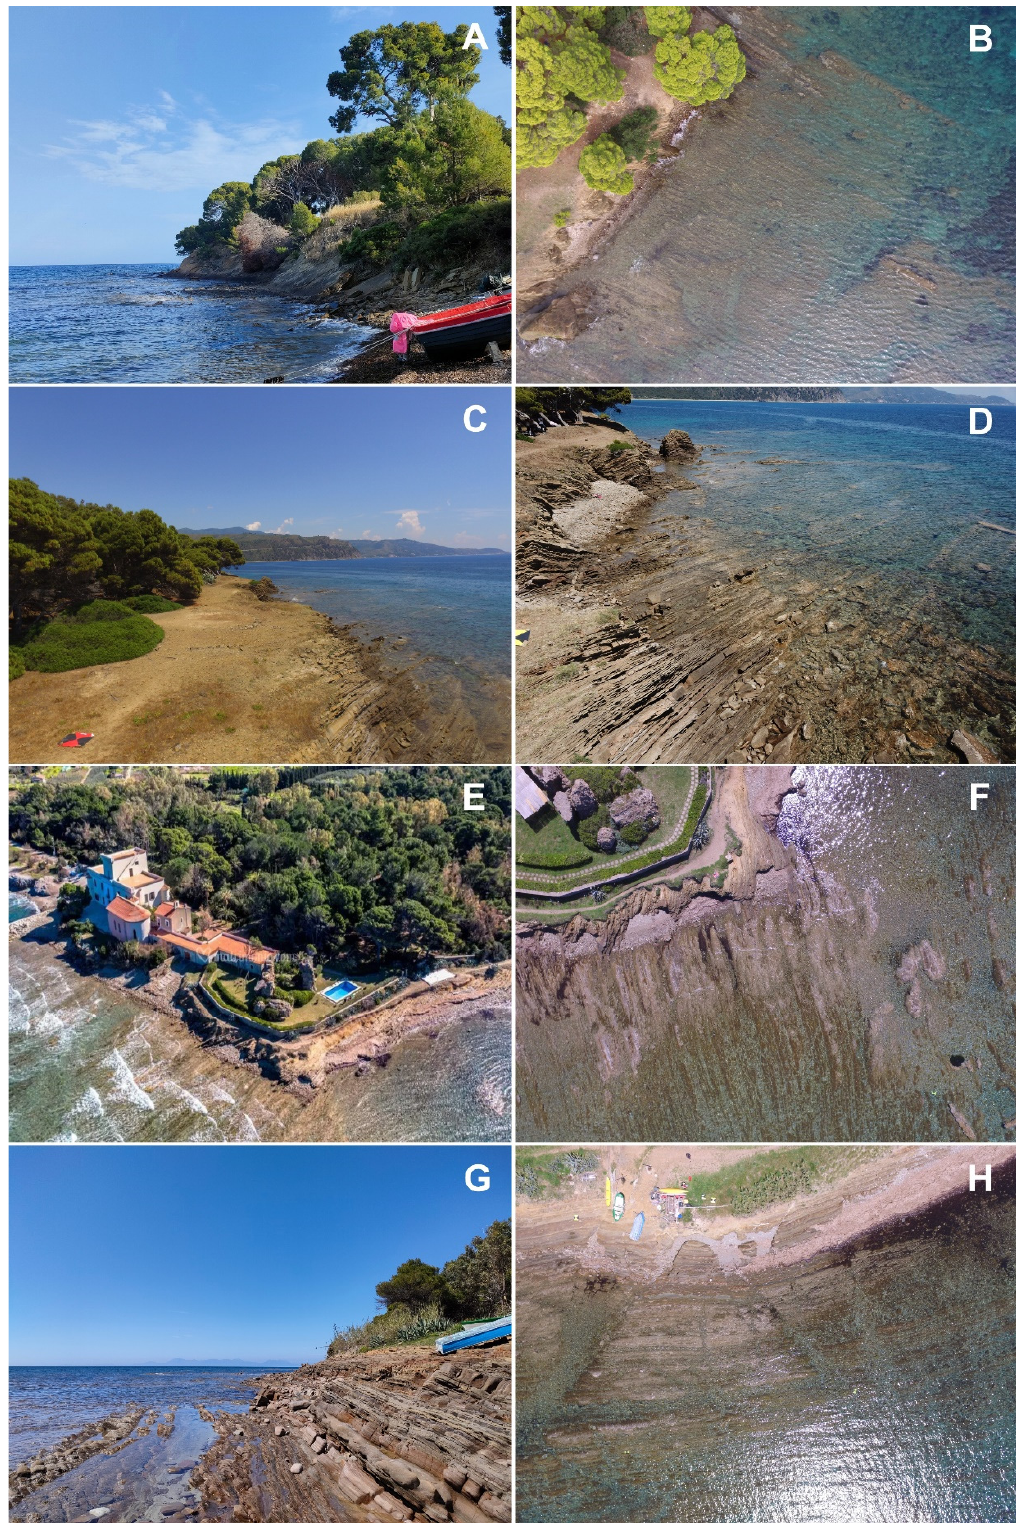
Figure 5. Detail of the two sites investigated through UAV Survey: ( A – D ) Punta Ogliastro; ( E – H ) Punta Licosa. Location is shown in Figure 4.